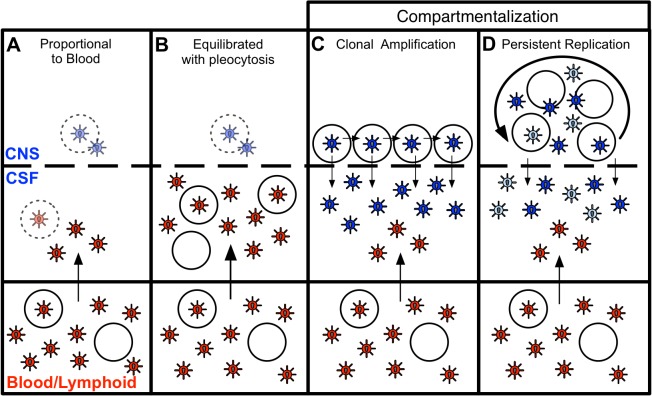
Four states can define the relationship between virus in the CSF/CNS and blood early during infection.Blood and CSF/CNS compartments are indicated. Blood plasma viral variants are represented by the red virus particles; and CNS viral variants are represented by the blue virus particles. CD4+ T cells are represented by open circles. Arrows indicate direction of virus movement between compartments. (A) State with a CSF HIV-1 RNA level 1–2% of the viral load in the blood and defined by minimal to no local CNS replication or inflammation, resulting in an equilibrated state between the two compartments (when CSF viral load high enough for analysis). Transparent infected CD4+ T cell represents potential local CNS replication that may be obscured by the import of virus into the CNS from the periphery. (B) State of equilibration between CSF and blood accompanied by high levels of pleocytosis, potentially caused by local CNS replication. Transparent infected CD4+ T cell represents potential local CNS replication likely obscured by the high levels of virus secreted by the infiltrating CD4+ T cells. (C) State of CSF/CNS clonal amplification of identical or nearly identical variants within CD4+ T cells. These clonally amplified populations are characterized by low diversity, signified by all CSF viruses in a single shade of blue. (D) State of genetically complex, compartmentalized viral replication within CD4+ T cells in the CSF/CNS indicative of persistent replication beyond a single clonal amplification event; this complexity is signified by CNS viral variants in multiple shades of blue.